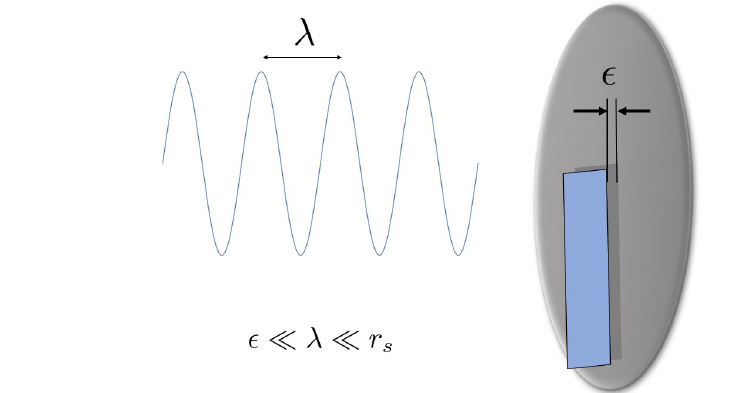
Figure 3 : A ‘membrane’ EFT regime for which hypothetical UV physics modifies near- horizon properties, for which the cutoff scale is much smaller than the length of any low- energy probe, which is in turn much smaller than the horizon scale (cid:15) (cid:28) λ (cid:28) r